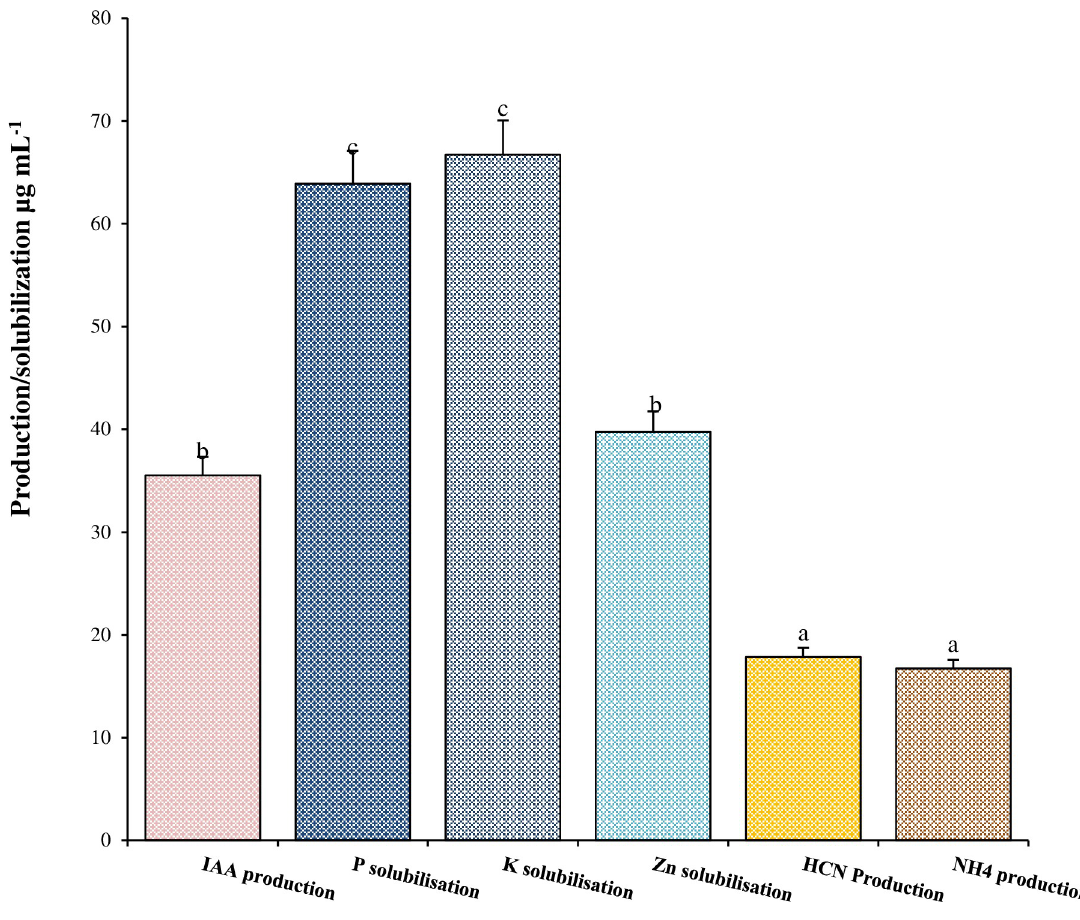
Fig 2. Plant growth promoting activities of the strain